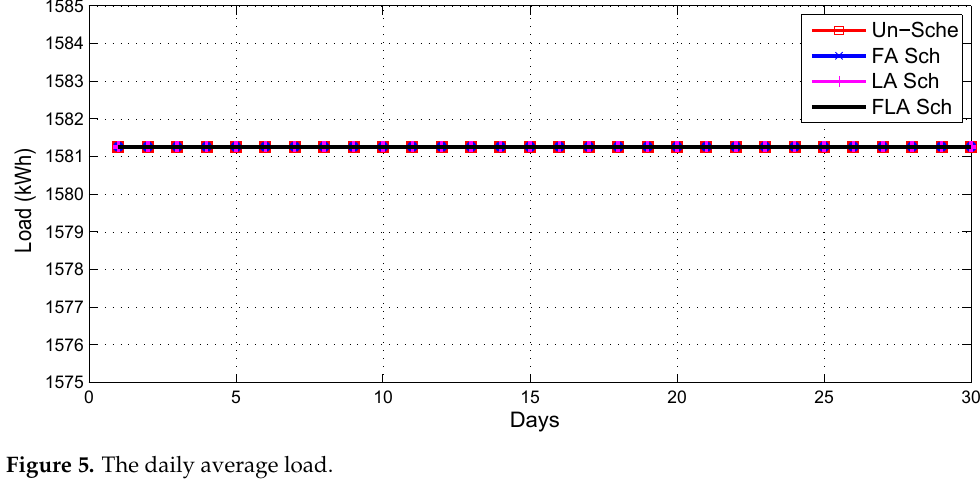
Figure 5. The daily average load.